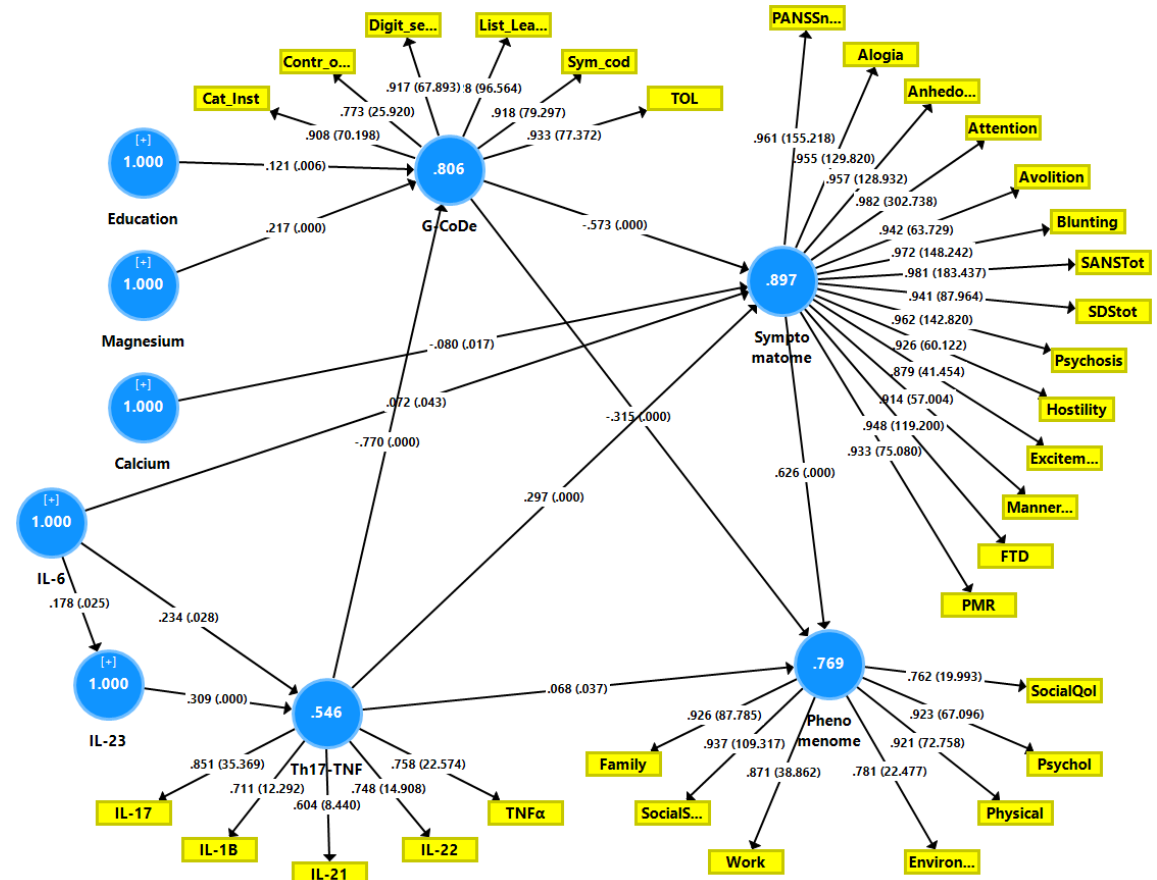
Figure 1. Results of Partial Least Squares (PLS) path analysis. This PLS analysis examines the associations between the DisQoL phenomenome, a latent vector (LV) extracted from three Sheehan disability (Dis) domains and four health-related quality of Life (QoL) data as the final outcome variable. Input variables include education, magnesium, calcium, interleukin (IL)-6 and IL-23 (entered as single indicators), the T helper (Th)17-TNF axis, a LV extracted from IL-17, IL-1 β , IL-21, IL-22 and tumor necrosis factor (TNF)- α , the G-CoDe (a LV extracted from the cognitive test results) and the symptomatome (a LV extracted from the negative PANSS score, the total SDS score, the SANS items and total score and other symptoms, including psychomotor retardation (PMR) and formal thought disorders (FTD). PANNS: Positive and Negative Syndrome Scale, SANS: Scale for the Assessment of Negative Symptoms, SDS: Schedule for the Deficit Syndrome; Cat_inst: Category Instances; Contr_0: Controlled Word Association; Digit_s: Digit Sequencing Task; List_Lea: List Learning; Sym_cod: Symbol coding; TOL: Tower of London. Shown are path coefficients with p -value, the factor loadings with p -value and average variances explained (white figures in the blue